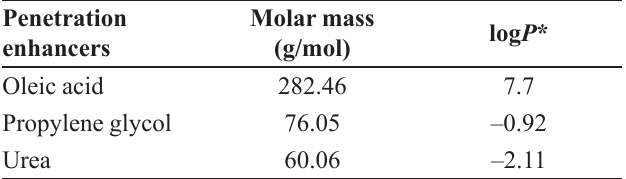
TABLE II - Physicochemical properties of penetration enhancers